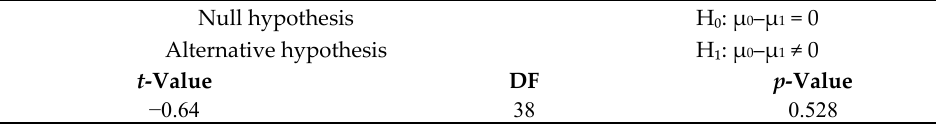
Table 10. Analysis of variance of age.